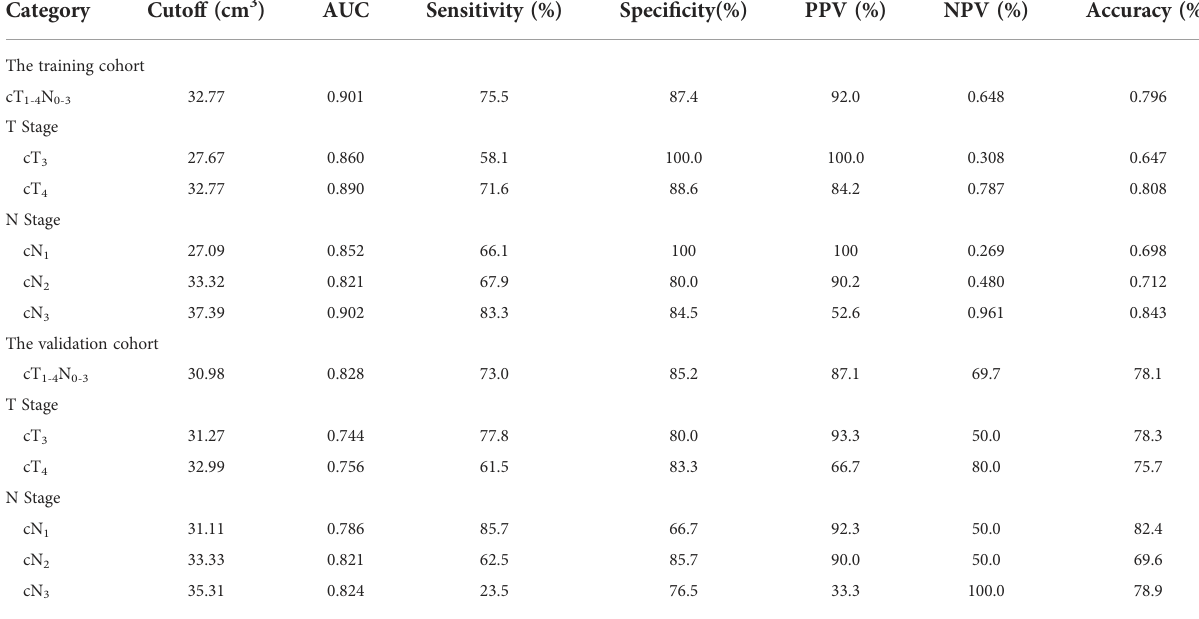
TABLE 4 Receiver operating characteristic analysis of gross tumor volume corresponding to cT and cN stages for determining resectability of adenocarcinoma of the esophagogastric junction in the training and validation cohorts.